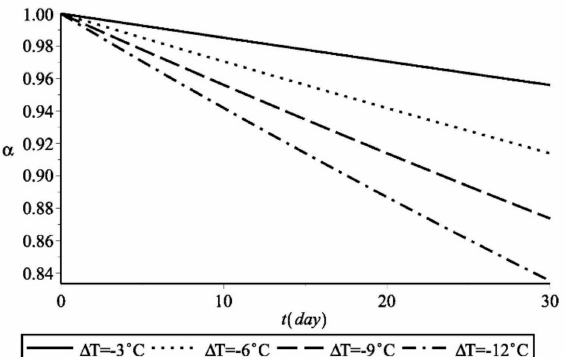
Figure 3. Variation trend over time in the isolated wave amplitude for di ff erent latitudinal di ff erences in temperature between the Arctic and Eurasia (unit: 1500 km).